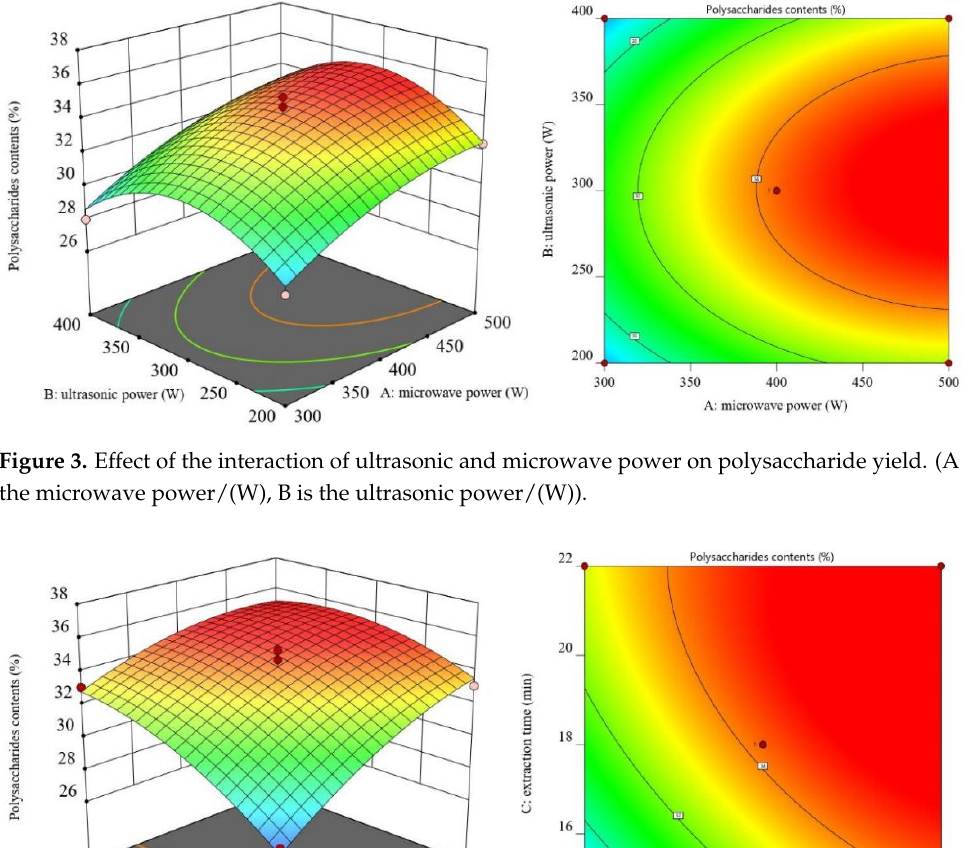
Figure 5. Effect of the interaction of microwave power and liquid-to-material ratio on polysaccha- ride yield. (A is the microwave power/(W), D is the liquid-to-material ratio/(g/mL)). Figure 6. Effect of the interaction of ultrasonic power and time on polysaccharide yield. (B is the ultrasonic power/(W), C is the extraction time/(min)).